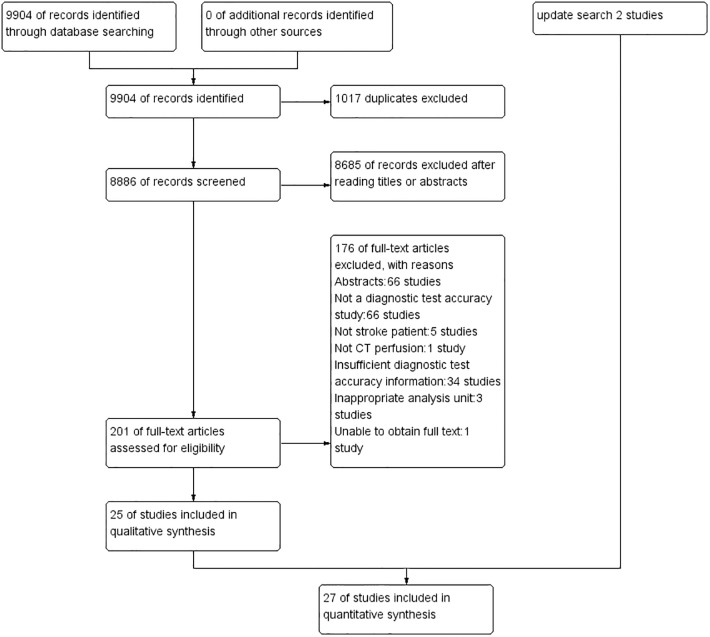
Study flow diagram.